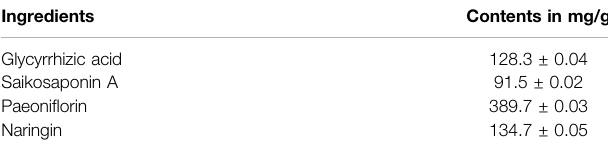
TABLE 1 | The contents of four major ingredients in the freeze-dried powder.